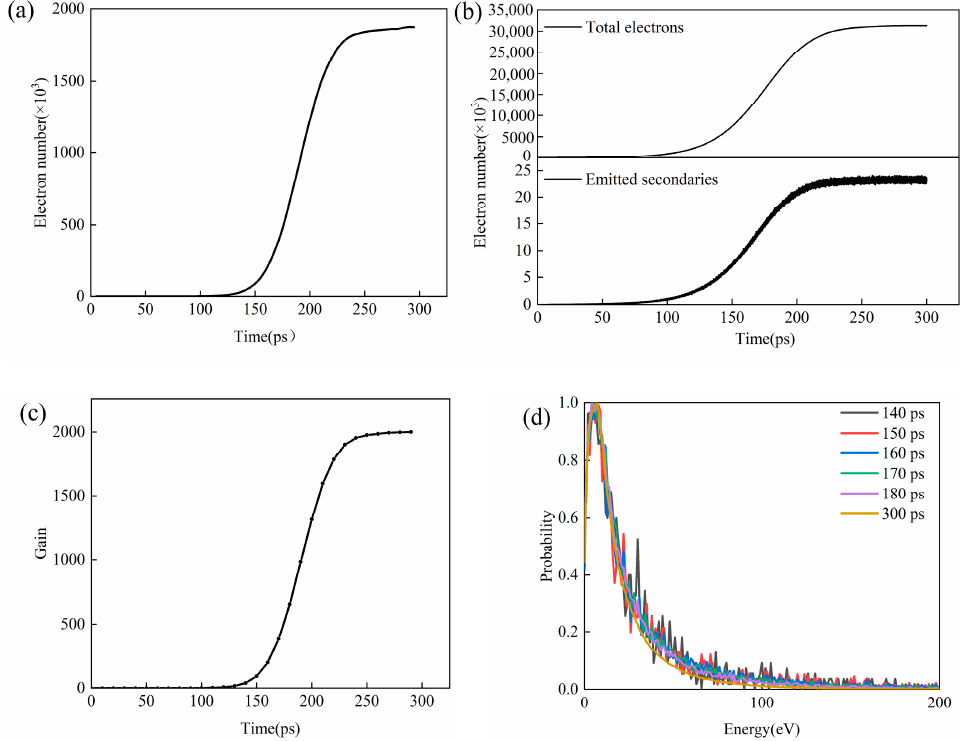
Figure 5. Simulation results of electron multiplication behavior of MCP with different transit times: ( a ) Accumulative electronic number at the output end; ( b ) Accumulative electronic number in the channel; ( c ) Gain; ( d ) The most probable exit energy distribution.